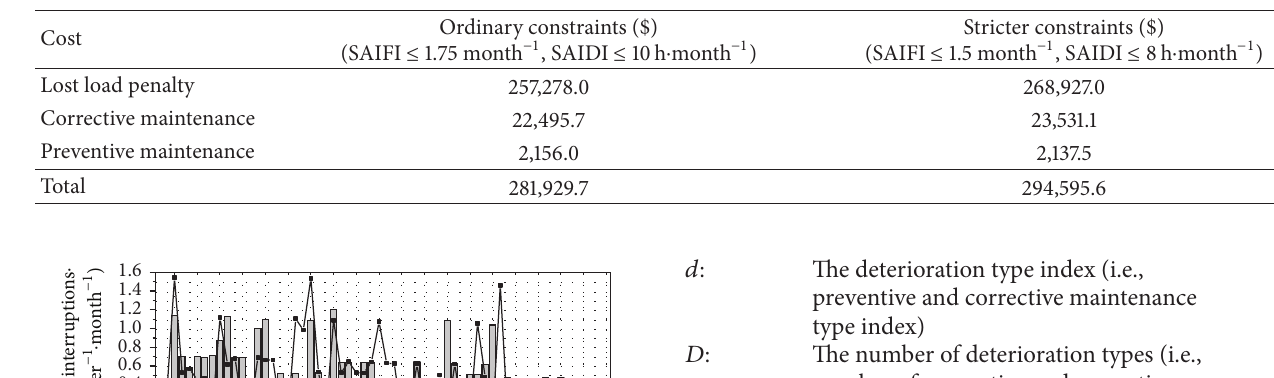
Table 7: System cost with different reliability requirements.